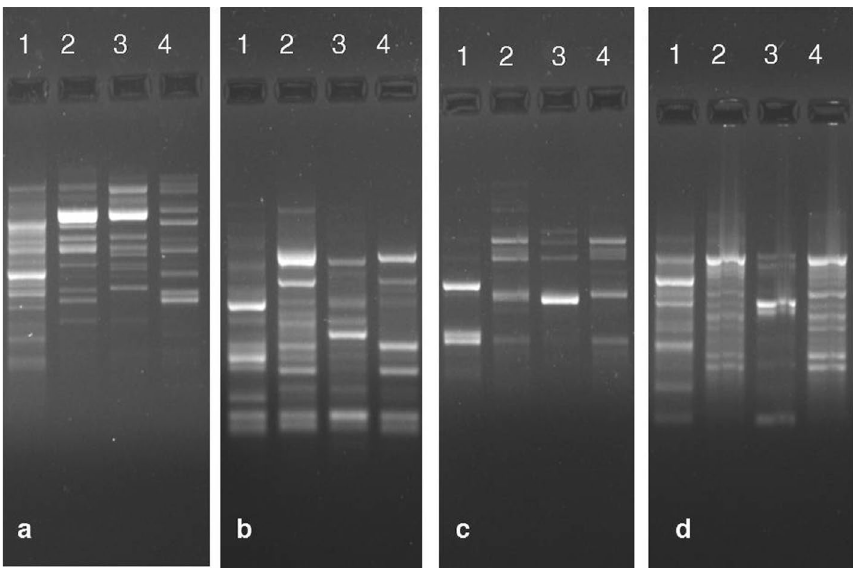
Figure 4. ISSR marker profiles of four dragon fruit genotypes ( a ) UBC900, ( b ) UBC811, ( c ) UBC 824 and ( d ) UBC835. [Lane 1—DGF1 ( H. undatus ); Lane 2—DGF2 ( H. costariscensis ); Lane 3—DGF3 ( H. megalanthus ) and Lane 4—DGF4 ( H. costariscensis